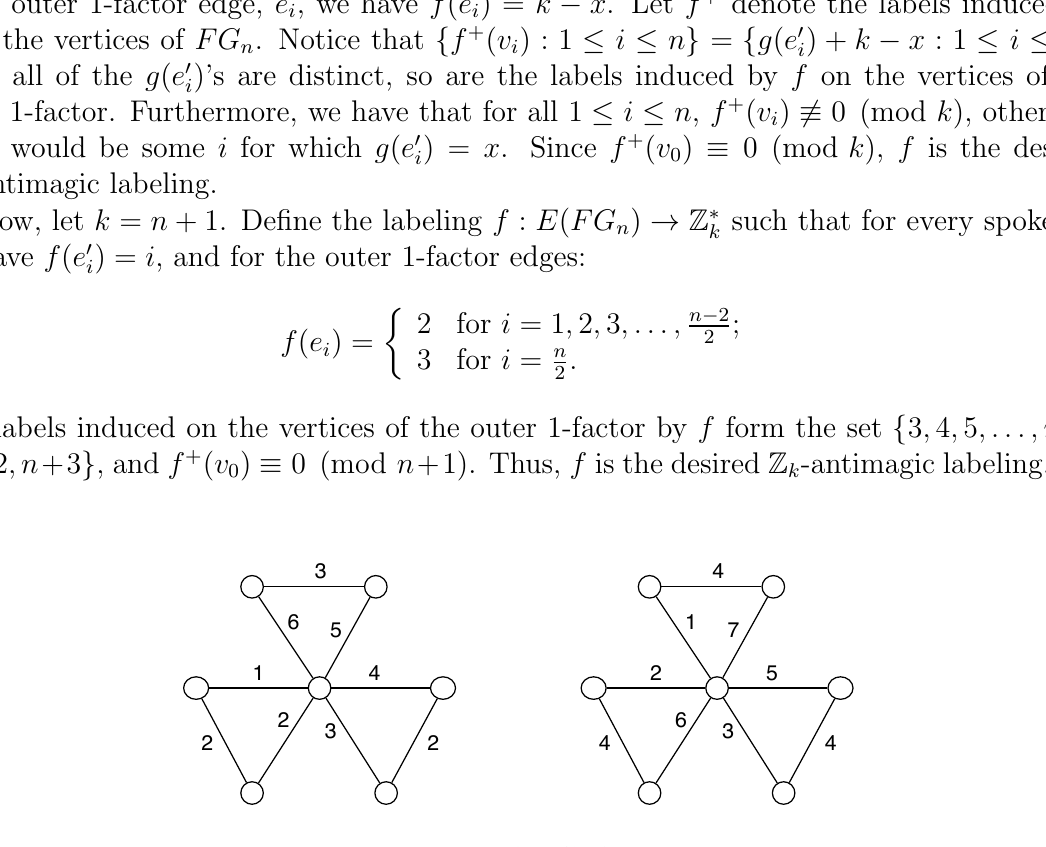
for k = 7 and 8, 6